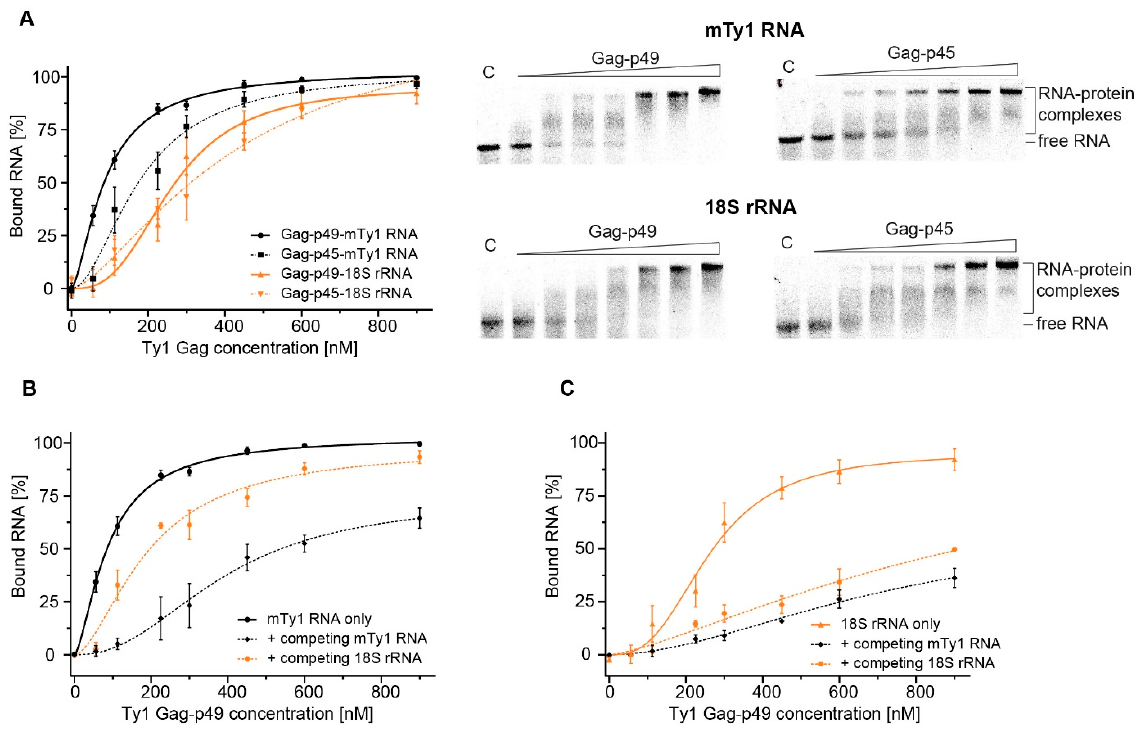
Figure 4. EMSA analysis of Ty1 Gag-RNA interactions. ( A ) Plots represent the fraction of bound mTy1 RNA (black) or 18S rRNA (orange) with increasing concentration of Gag-p49 (solid line) or Gag-p45 (dashed line) at 150 mM NaCl. Representative agarose gels are presented alongside the plots. Lanes denoted C lack protein. Effects of addition of competing mTy1 RNA (black, dashed line) or 18S rRNA (orange, dashed line) in 10-fold molar excess on Ty1 Gag-p49 interactions with mTy1 RNA ( B ) or 18S rRNA ( C ). The measurement of RNA binding by Ty1 Gag-p49 in 150 mM NaCl lacking competitor RNA is used as a control (solid